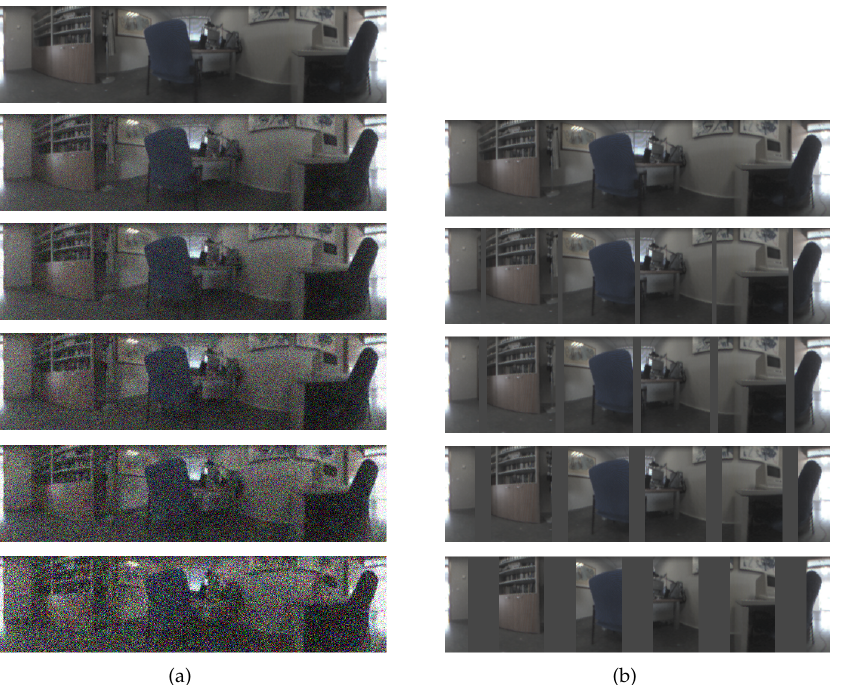
Figure 5. Sample image from the training test with ( a ) different levels of added Gaussian noise ( σ 2 = { 0,0.0025, 0.05,0.01,0.02, 0.05 } ) and ( b ) sequence of occlusions considered ( { 0,5, 10,20,40 }